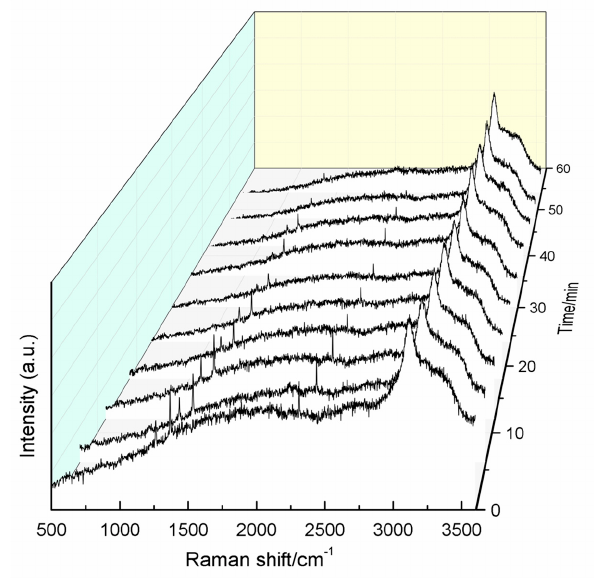
Figure 8. Raman spectra of hydrates formed in zeolite systems with different water contents at 271.2 K.